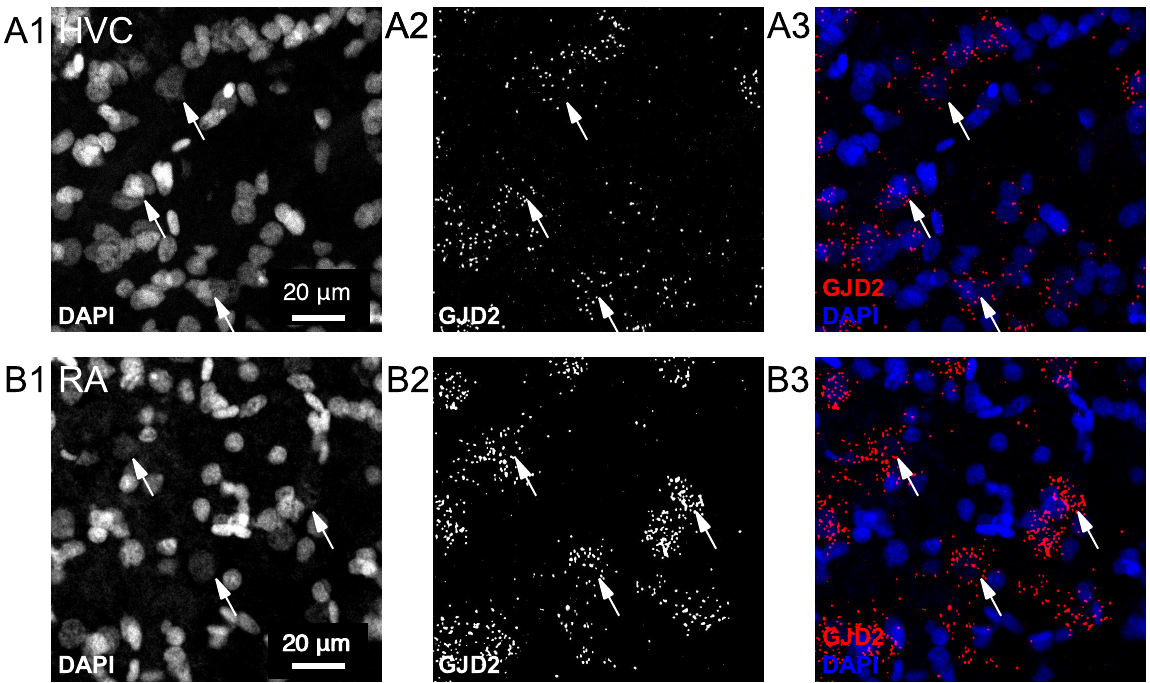
Figure 3. Expression of GJD2 mRNA in song nuclei HVC and RA from the zebra finch. GJD2 mRNA labeling was counterstained by the nuclear staining, DAPI. ( A1 – A3 ) expression of GJD2 mRNA in song nucleus HVC from zebra finches. ( B1 – B3 ) expression of GJD2 mRNA in song nucleus RA. Single confocal planes. Arrows point toward three GJD2 mRNA-positive cells in each